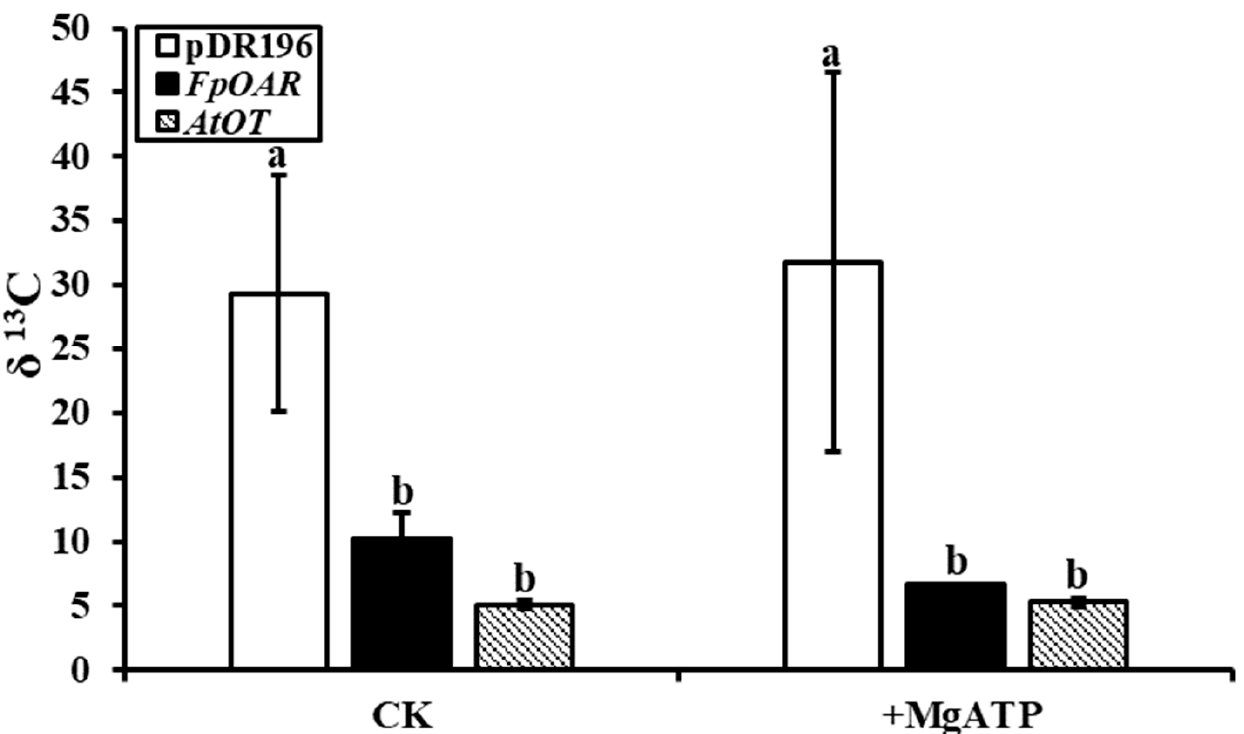
Figure 7. [ 13 C]oxalic acid residue in the filtrate of pDR196- (negative control), FpOAR - (positive con- trol), and AtOT -transformed yeast membrane vesicles. Different letters in the figure indicated sig- nificant differences among the recombinant yeast cells at p < 0.05.